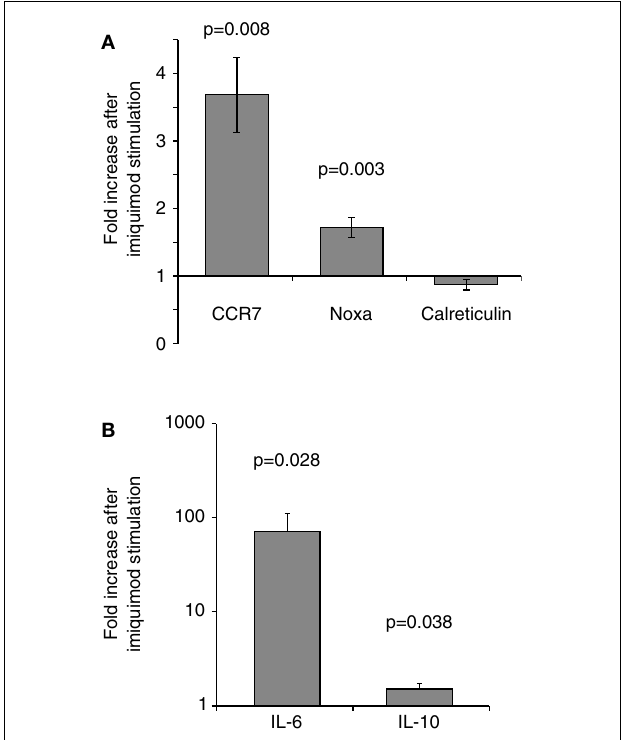
FIGURE 4 | Imiquimod stimulates LCLs to express cytokines and interferon-response genes . LCLs were generated by EBV infection of cells from healthy volunteers. Cells were treated with imiquimod. (A) Expression of the interferon-response genes CCR7, NOXA, and Calreticulin were measured using SYBR Green real-time PCR.The figure shows the fold increase in gene expression after imiquimod stimulation for each gene. CCR7 and NOXA were significantly upregulated after imiquimod stimulation ( p = 0.008 and p = 0.003, respectively). (B) Expression of cytokine RNA was measured using SYBR Green real-time PCR. IL-6 expression was upregulated by 71-fold after imiquimod stimulation ( p = 0.028). IL-10 expression was also significantly upregulated ( p = 0.038), although to a much lesser extent, at 1.5-fold. N = 12 for each